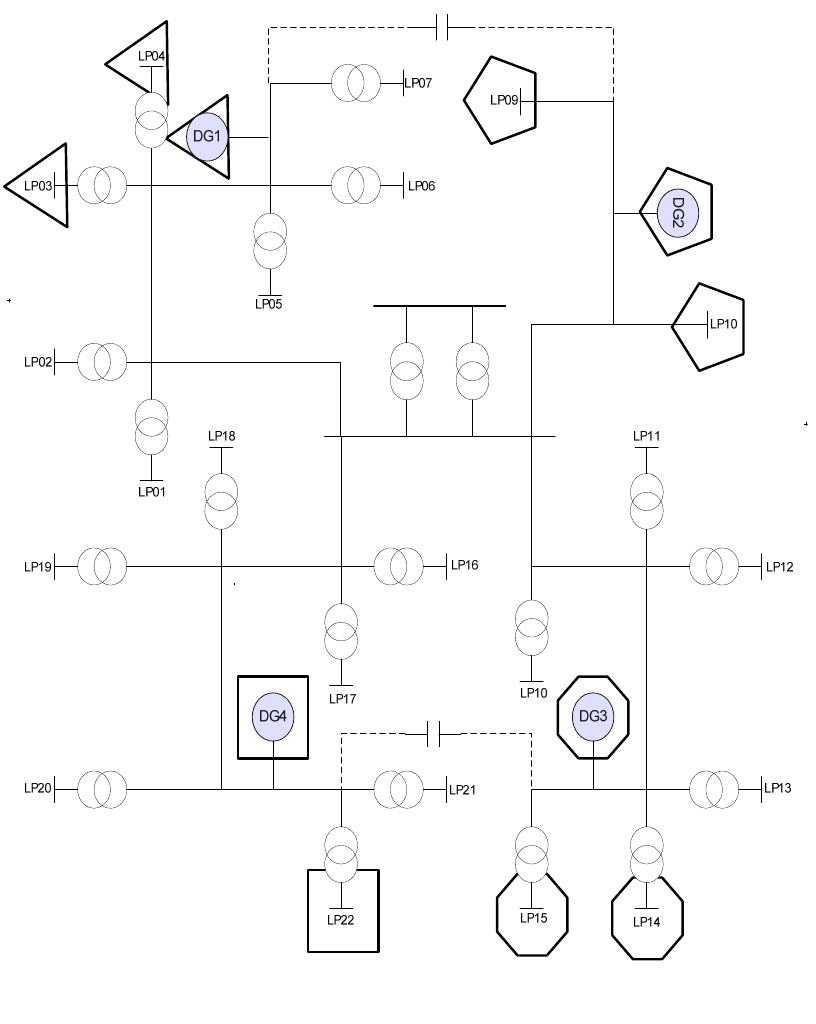
Figure 8. Optimal configuration of RBTS 2BUS